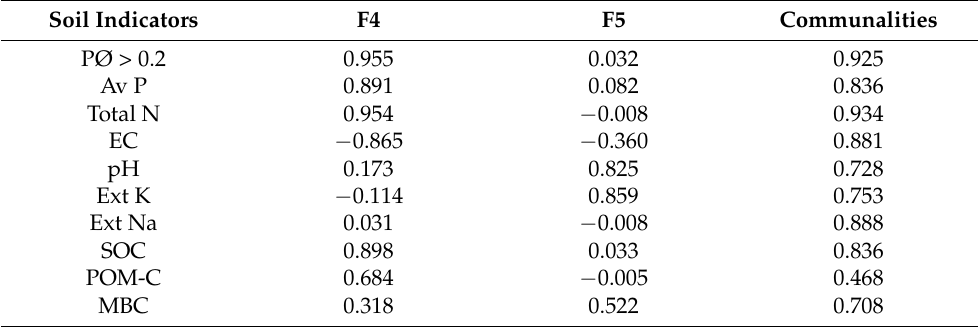
Table 6. Proportion of variance explained using varimax rotation for each of the retained factors and communalities for the selected soil properties for the 15–30 cm